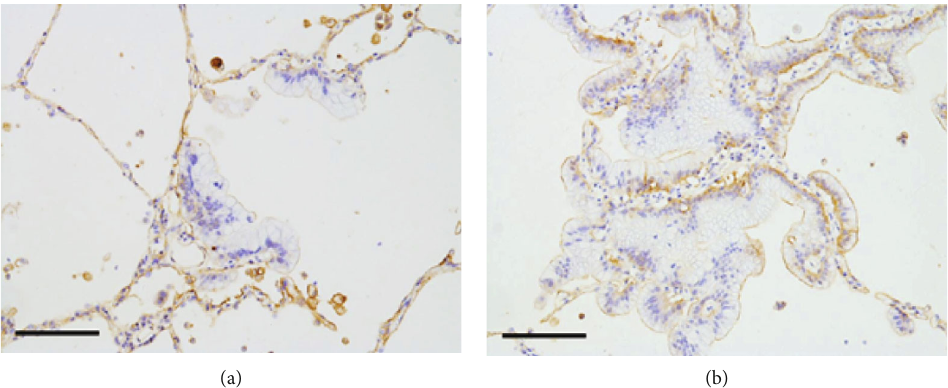
Figure 7: ANX A2 immunostaining of microscopic aerogenous metastases in the left lung. (a) No distinct positivity is visible in the minute foci. Scale bar: 200 μ m. (b) Basal-side cytoplasmic positivity is detected in the larger metastatic foci. Scale bar: 200 μ